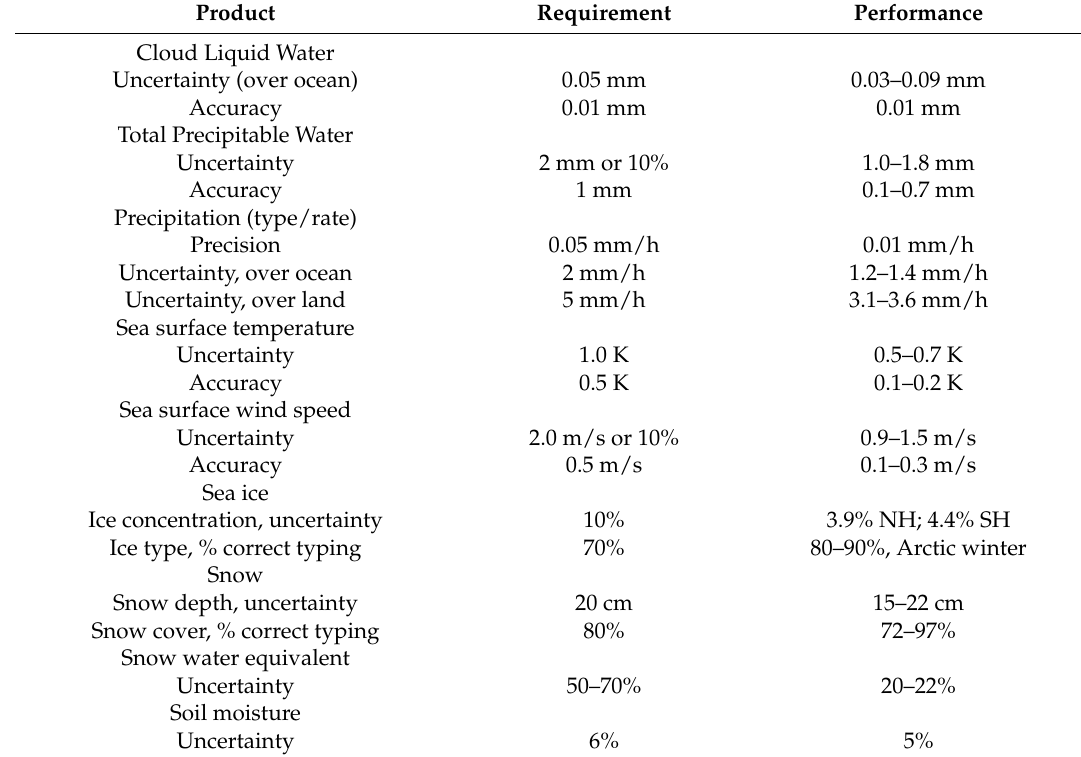
Table 15. GCOM-AMSR2 products